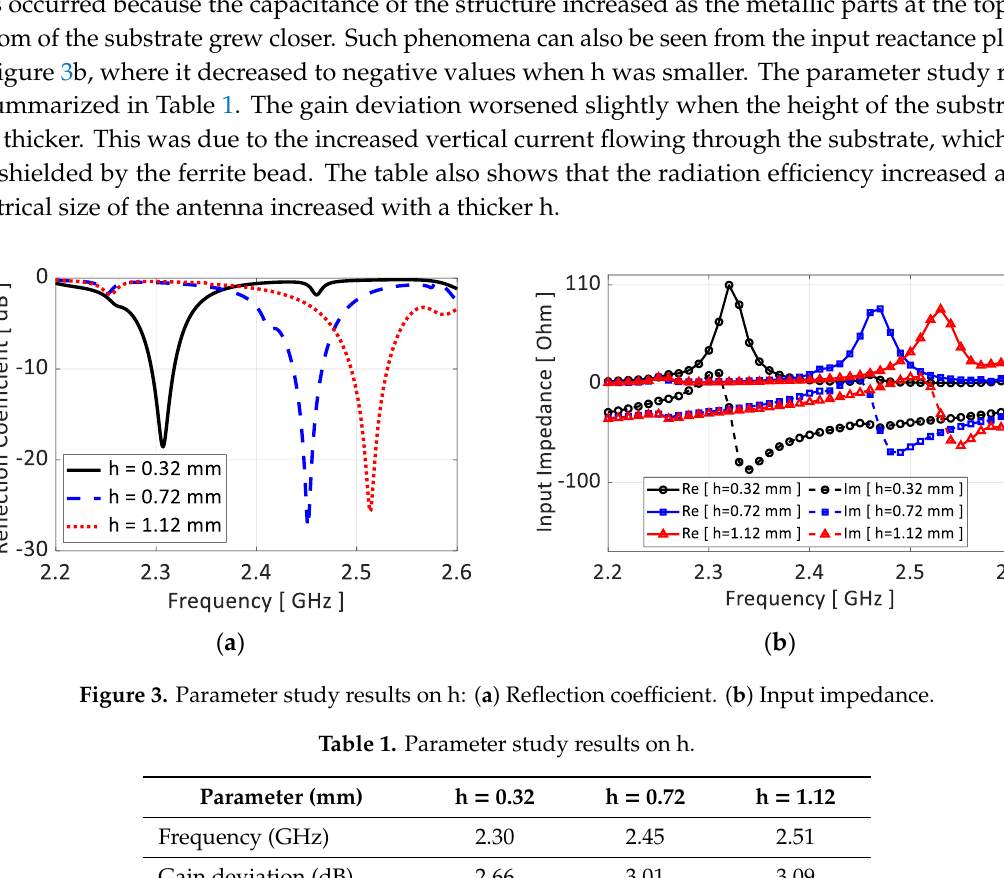
Table 1. Parameter study results on h.